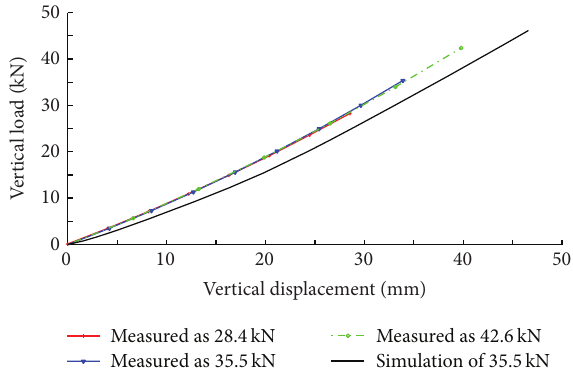
Figure 5: Comparison of the simulated load-deflection characteris- tics with the